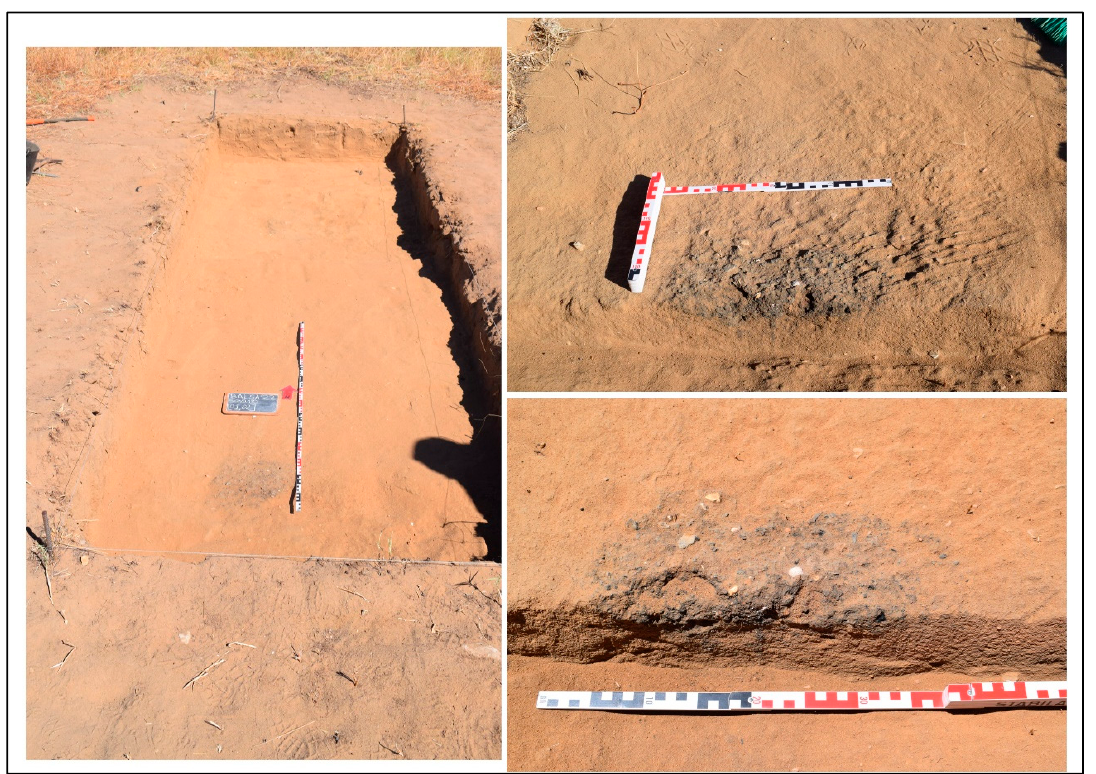
Figure 15. Sounding opened in P1-3, with the remains of planting pits visible.